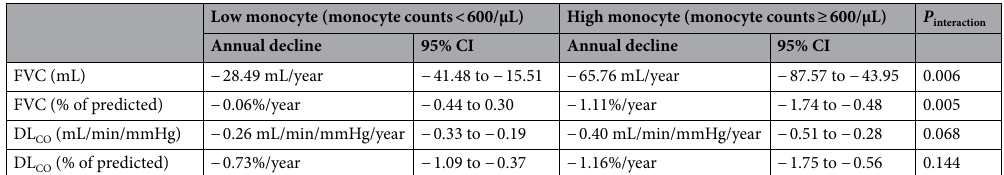
Table 3. Annual average changes in lung function in the included patients according to blood monocyte counts. CI, confidence interval; FVC, forced vital capacity; DL CO , diffusing capacity of the lung for carbon monoxide. The interaction according to time between high and low monocyte groups was analyzed using the type III test, and the P value of the test was expressed as P interaction .